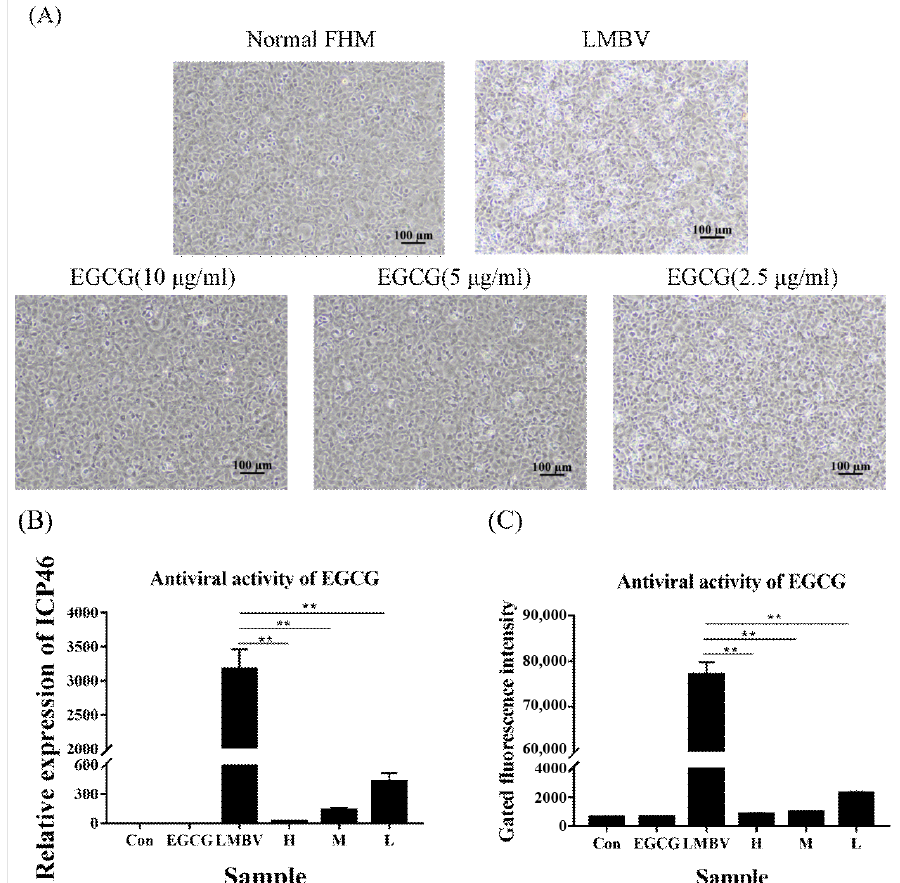
Figure 2. Analysis of the antiviral activity of EGCG. ( A ) Light microscopy of CPEs in each group; almost no CPEs appeared in the non ‐ treatment group. Compared to the large number of CPEs in the virus infection group, CPEs in the EGCE treatment group were obviously lacking. Among the treatment groups, the number of CPEs was lowest at 10 μ g/mL, followed by 5 μ g/mL and then 2.5 μ g/mL. ( B ) The results of flow cytometry analysis showed that the fluorescence intensity of the FHM cells incubated with different concentrations of EGCG as well as LMBV was significantly weaker than that of the cells treated with LMBV only. ( C ) RT ‐ qPCR detection showed that the expression of viral ICP46 in FHM cells was significantly reduced after incubation with different concentrations of EGCG. All of these results indicated that EGCG inhibited LMBV infection in a dose ‐ dependent manner. ** indicates p < 0.01.